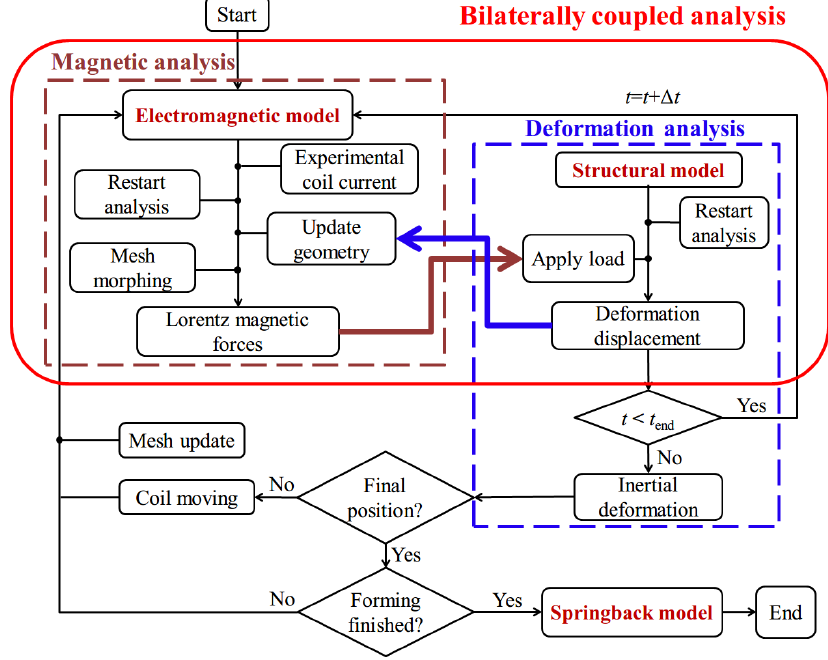
Figure 7. Flowchart of FE (finite element) model of EMIF for stiffened panels.